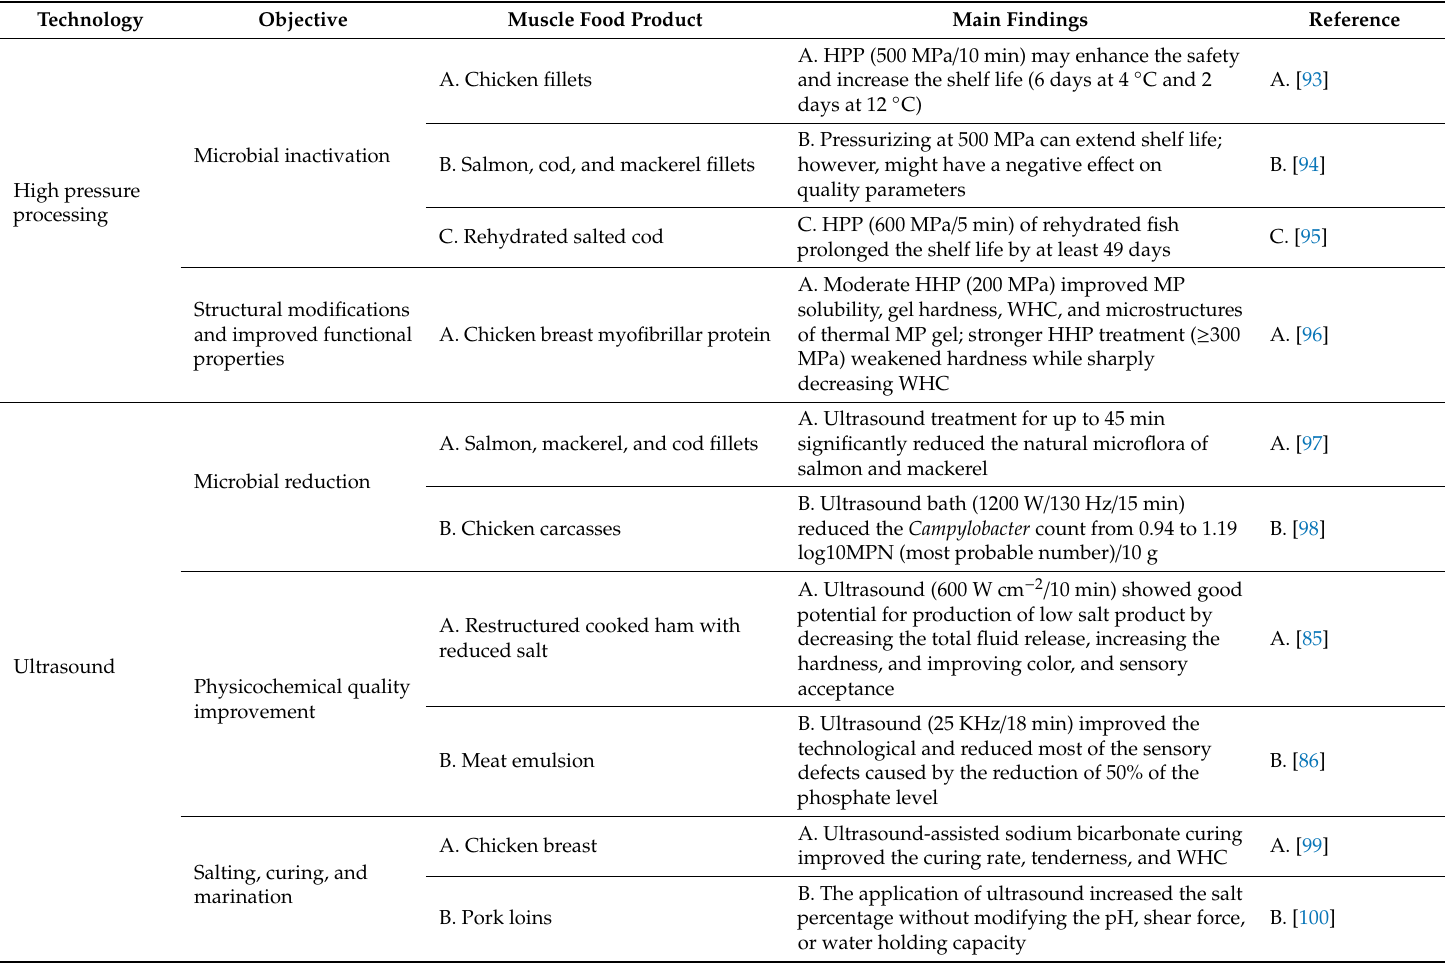
Table 2. Some examples of non-thermal technologies utilized for muscle food